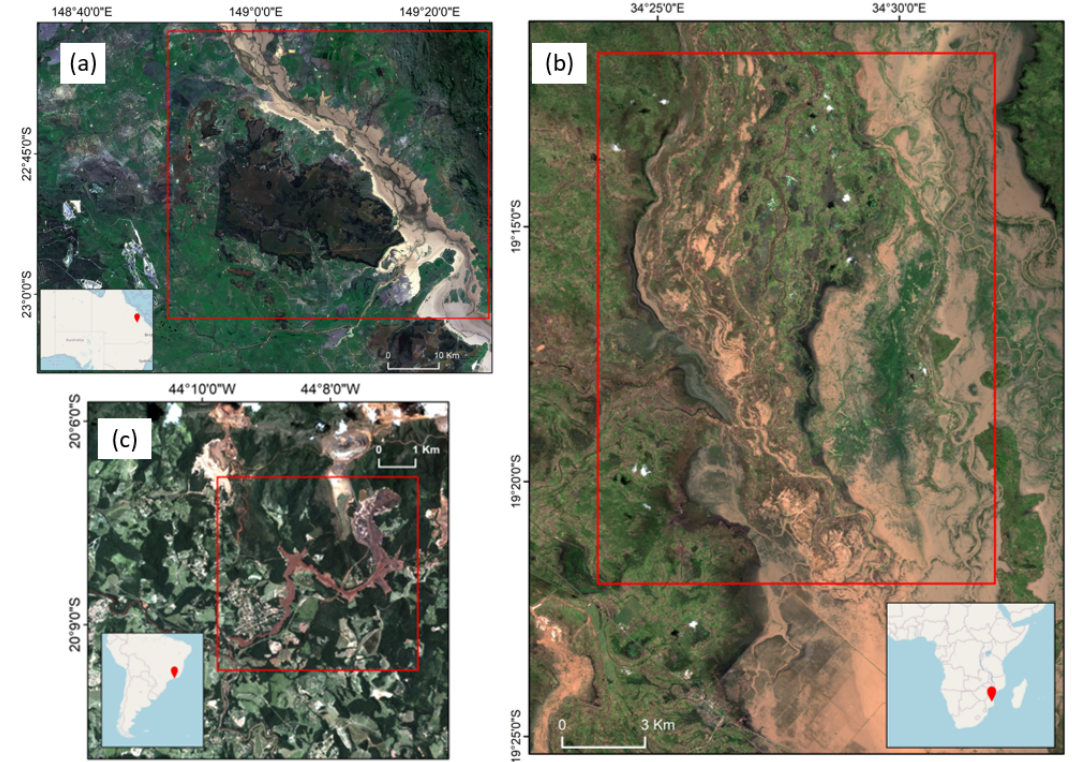
Figure 3. Sentinel 2 optical data showing the location of the three study sites: ( a ) Queensland, Australia, ( b ) Mozambique ( b ), and ( c ) Brumadinho, Brazil.